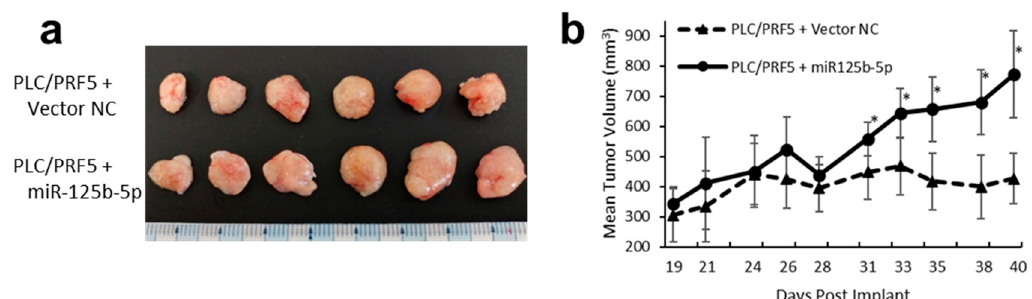
Figure 8. PLC/PRF/5 cells treated with miR-125b-5p expressing vector or negative control (NC) vector were implanted s.c. in the flank of mice (5 × 10 6 per animal). Treatment was initiated on day 19 when all tumors reached 200 mm 3 in size. Sorafenib or vehicle control was administered orally, once a day, for 21 days at a dose of 30 mg/kg. There was no lethality in any group. ( a ) Images of the tumors from all mice in each group ( n = 6). ( b ) Tumor dimensions were recorded three times a week starting with the first day of treatment ( n = 6). Data represent mean ± SD. * p < 0.05 compared with the control group.